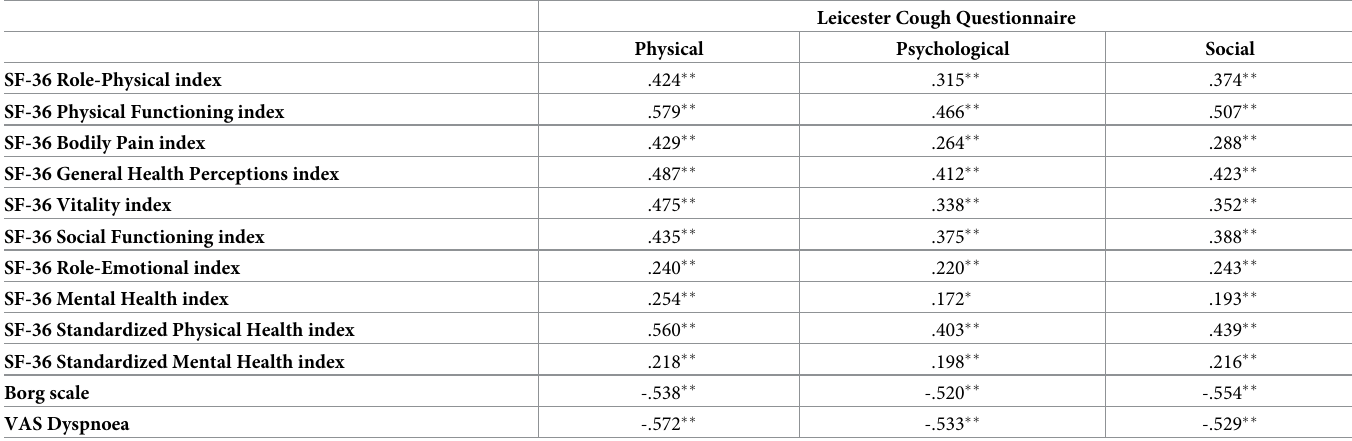
Table 4. Concurrent